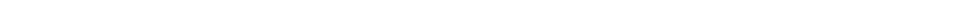
Fig. 5 mstnb and inhbaa inversely regulate the activities of Smad2 and Smad3 response elements, as well as Smad3 phosphorylation. a RT-qPCR analysis for relative EGFP mRNA expression in 48 hpf Tg(ARE:EGFP) embryos injected with mstnb , inhbaa , mstnb-2A-H2B-mcherry, and inhbaa-2A-H2B-mcherry mRNA compared to RFP mRNA injected ( n = 2 × 10 embryos assessed as 2 biological and 2 technical replicates). b RT-qPCR analysis for relative EGFP mRNA expression in 48 hpf Tg(12XSBE:EGFP) embryos injected with mstnb , inhbaa , mstnb-2A-H2B-mcherry , and inhbaa-2A-H2B-mcherry mRNA compared to RFP mRNA injected ( n = 2 × 10 embryos assessed as two biological and two technical replicates). c , d Sections of wild-type sibling and mstnb OE cryoinjured hearts at 14 dpci; pSmad3 (green), α -MF-20 (red), DAPI (blue). White dotted regions delineate the injured area. White arrowheads point to pSmad3 + CMs near the injured area. e Quanti fi cation of pSmad3 + CMs in wild-type sibling ( n = 4) and mstnb OE ( n = 5) cryoinjured hearts in the 100 µ m region adjacent to the injured area at 14 dpci. f , g Sections of wild-type sibling and inhbaa OE cryoinjured hearts at 14 dpci; pSmad3 (green), α -MF-20 (red), DAPI (blue). h Quanti fi cation of pSmad3 + CMs in wild-type sibling ( n = 3) and inhbaa OE ( n = 4) cryoinjured hearts in the 100 µ m region adjacent to the injured area at 14 dpci. i , j Sections of mstnb + / + and mstnb − / − cryoinjured hearts at 14 dpci; pSmad3 (green), α -MF-20 (red), DAPI (blue). k Quanti fi cation of pSmad3 + CMs in mstnb + / + ( n = 4) and mstnb − / − ( n = 4) cryoinjured hearts in the 100 µ m region adjacent to the injured area at 14 dpci. l , m Sections of inhbaa + / + and inhbaa − / − cryoinjured hearts at 14 dpci; pSmad3 (green), α -MF-20 (red), DAPI (blue). n Quanti fi cation of pSmad3 + CMs in inhbaa + / + ( n = 4) and inhbaa − / − ( n = 5) cryoinjured hearts in the 100 µ m region adjacent to the injured area at 14 dpci. All cell counts were performed on three sections from each heart. Each data point on dot plot represents one heart (data are mean ± s.e.m., * P ≤ 0.05, ** P ≤ 0.01, *** P ≤ 0.001 and **** P ≤ 0.0001 — Student ’ s t test, two-tailed). Scale bars, 100 µ